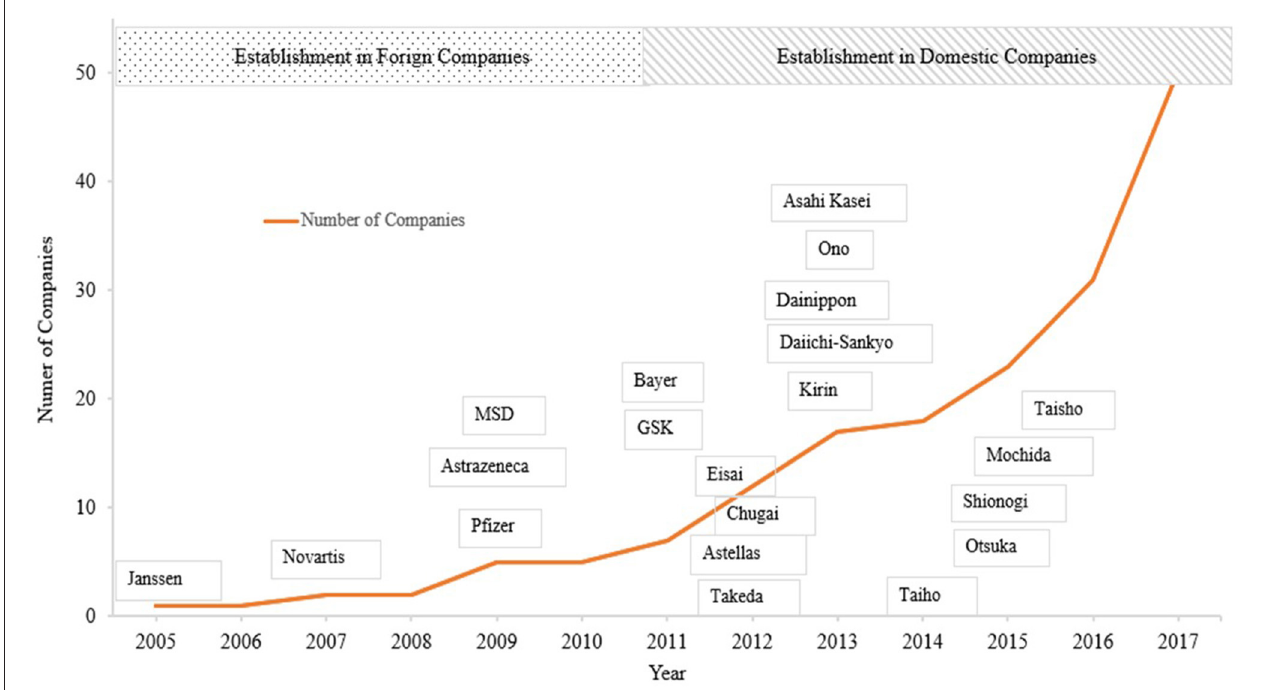
FIGURE 1 | Establishment of MA departments for pharmaceutical companies in